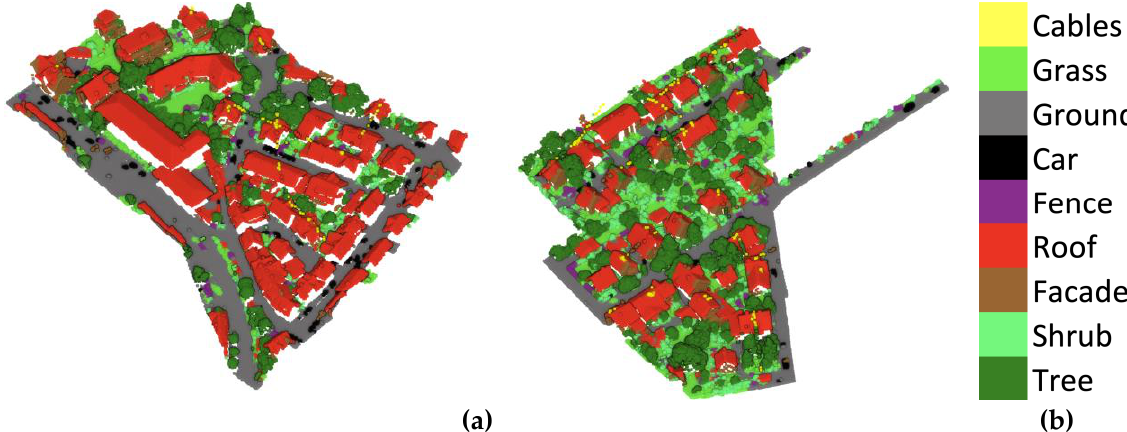
Figure 13. ( a ) Classification result of the ISPRS Vaihingen dataset with the 2DCNN approach. ( b ). Legend. Table 8. Average and weighted F1 and IoU scores for 2DCNN and 3DCNN classifiers on the DALES dataset. The OA is also reported.